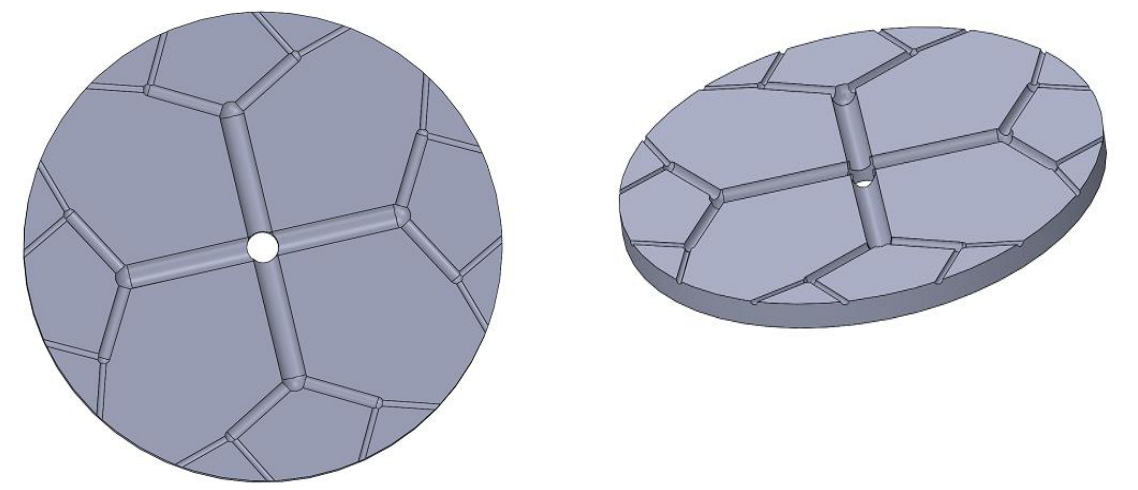
Figure 11. Two 3 – D renderings of the improved DSHE-C2. Figure 11. Two 3–D renderings of the improved